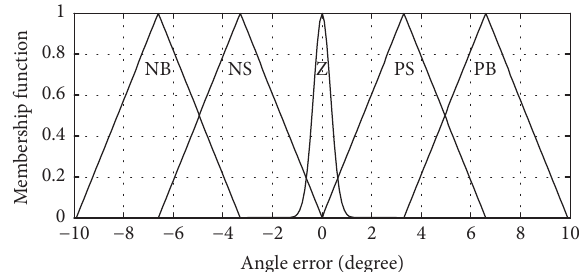
Figure 3: Fuzzy sets for angular displacement error.